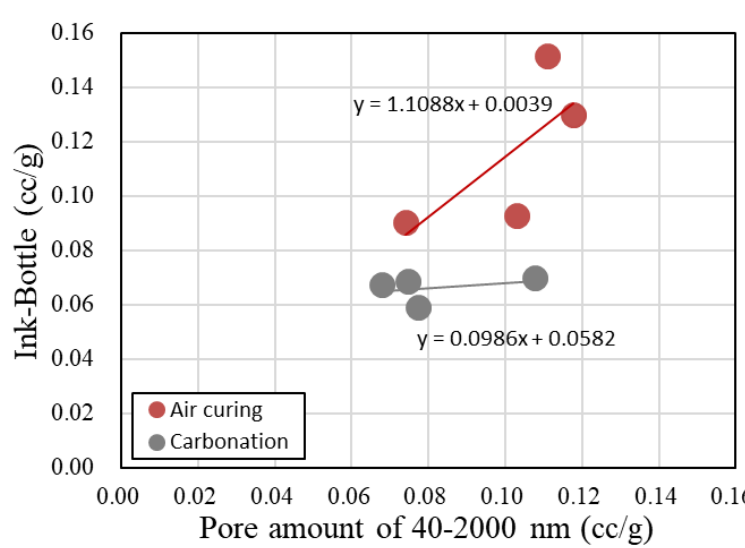
Figure 12. Relationship between 40–2000 nm pore volume and ink-bottle pore volume in carbonated cement paste.